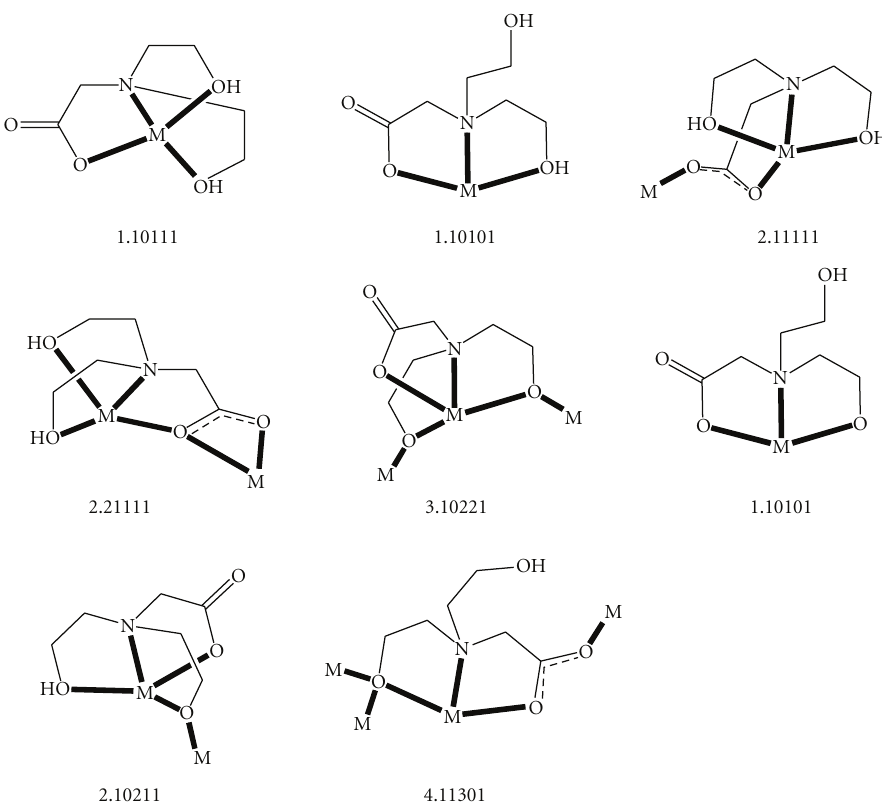
Scheme 2: The to-date crystallographically established coordination modes of the bicH 2 − , bicH 2 − , and bic 3 − ligands and the Harris notation in [10] that describes these